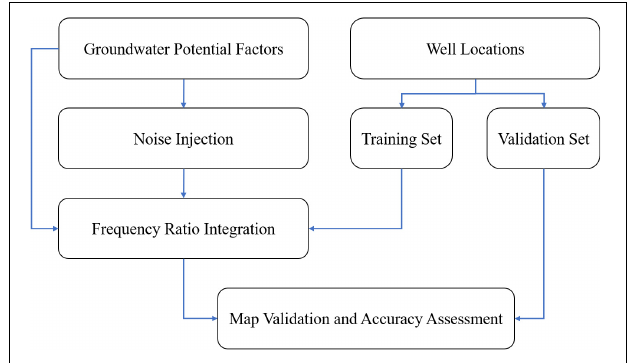
FIGURE 1 | The methodological framework of the